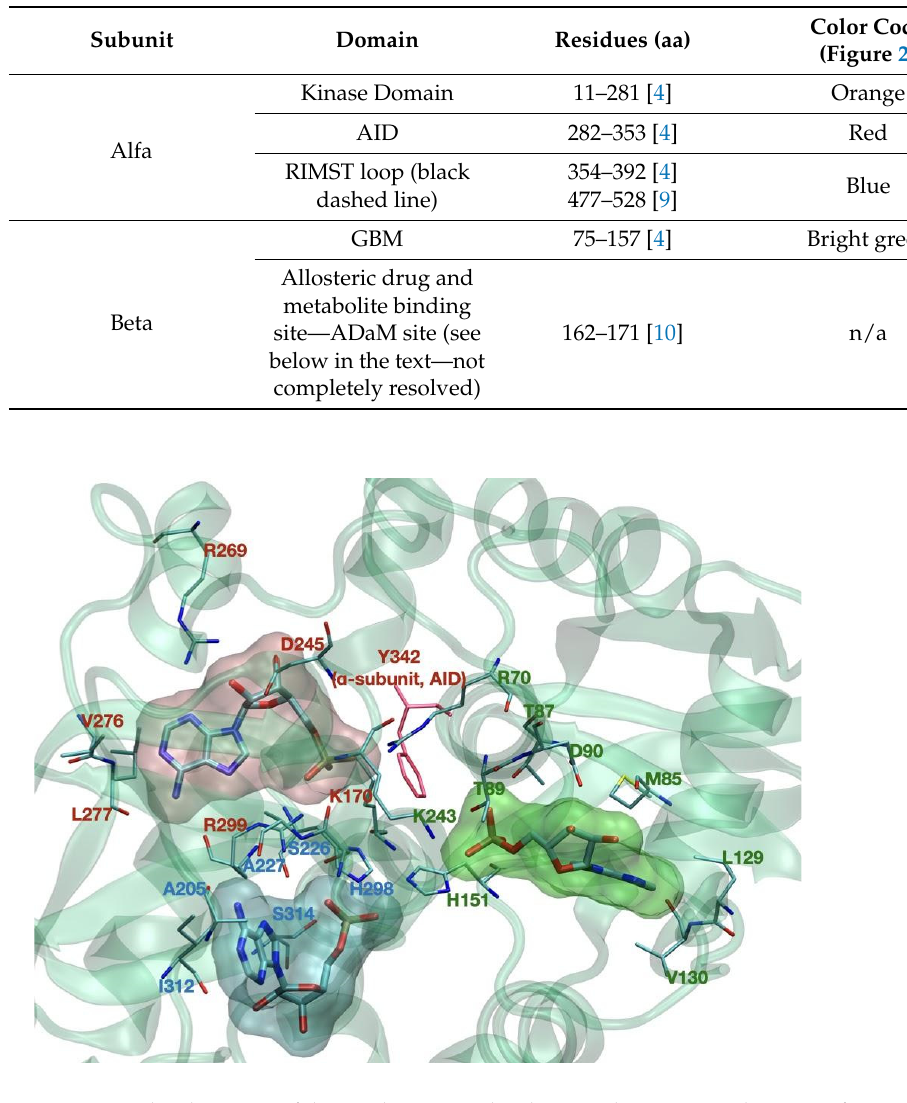
Table 1. Residue numbers for each highlighted domain.